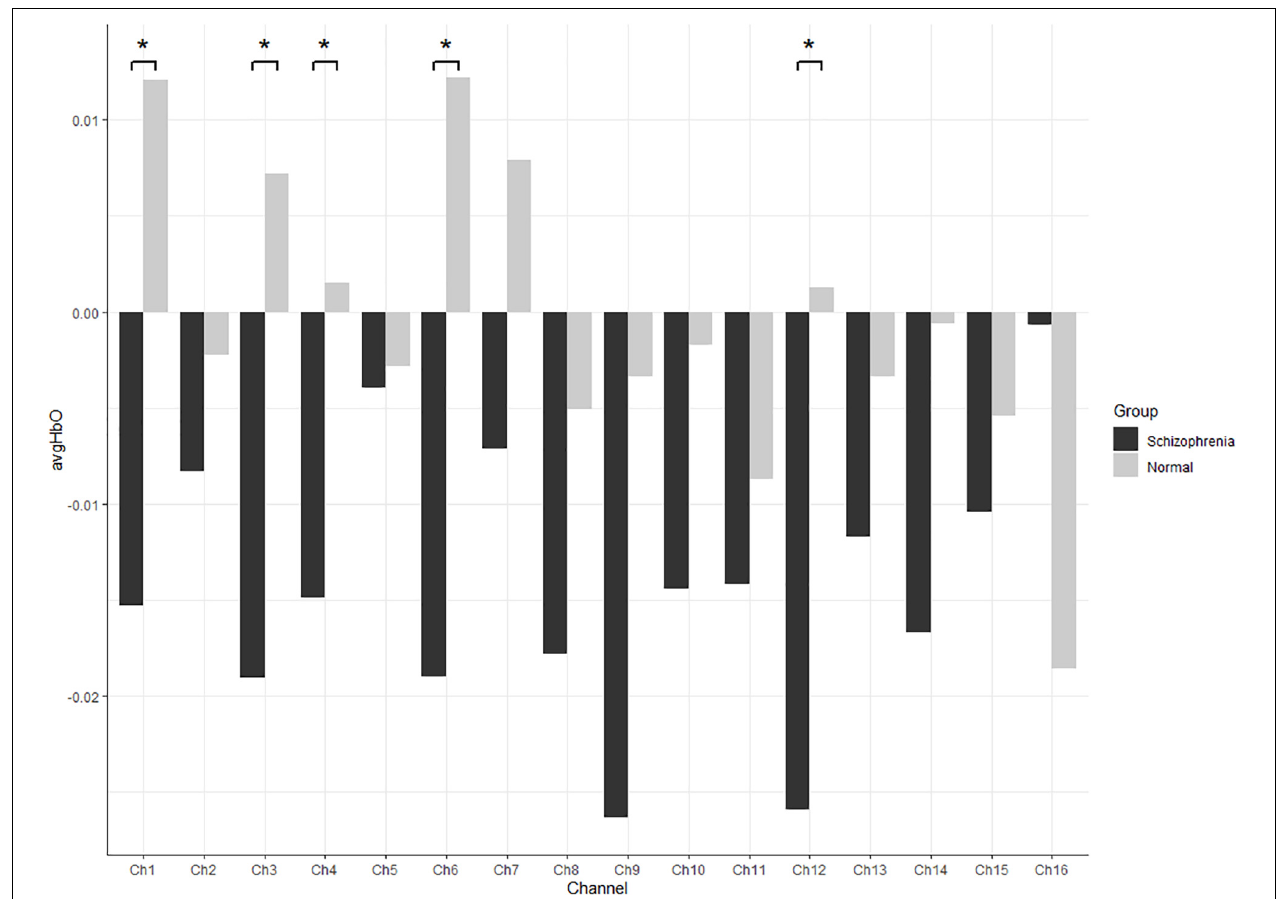
FIGURE 5 | All channels HbO concentrations in participants during emotion expression through drawing (* refer significant difference between two groups p < 0.05).